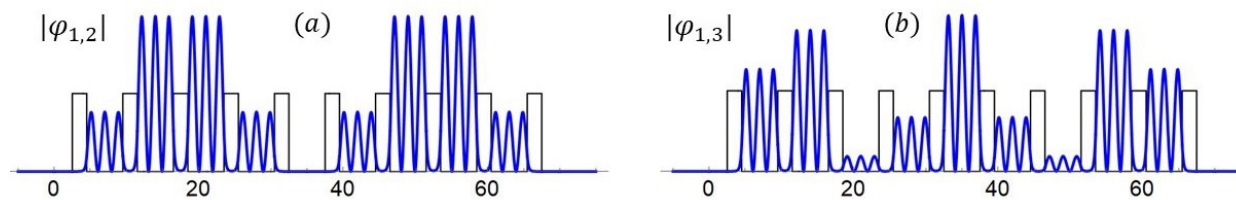
Figure 4. Resonant wave functions in an open GaN ( GaAlN / GaN ) n superlattice with n = 10. ( a ) The absolute value of the resonant function ϕ 1,2 , and ( b ) the absolute value of the resonant function ϕ 1,3 . These are exact solutions for the periodic potential, shown in the figure (black curve), but none of these functions satisfy Floquet’s